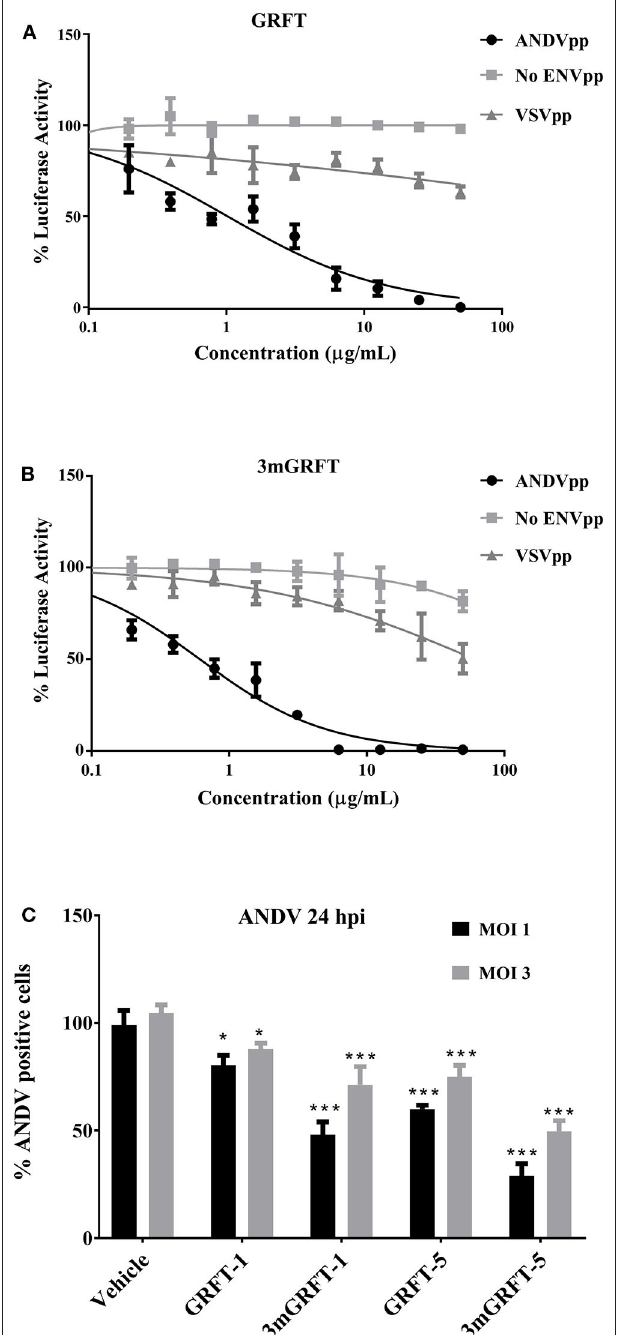
FIGURE 3 | GRFT and 3mGRFT affect viral entry. HIV particles bearing glycoproteins of ANDV or vesicular stomatitis virus (VSV) were prepared and used as previously described. Viral glycoprotein-dependent entry assays were performed using HT1080 cells pre-treated with serial dilutions of GRFT and inoculated with either ANDV pseudo-particles (pp) or control VSVpp in the presence of GRFT (A) or 3mGRFT (B) at increasing concentrations. Intracellular firefly luciferase signal was measured 72h post transduction and normalized to signal in untreated, untransduced cells. Graphs represent the mean ± SD and are representative of three independent experiments, (Continued)